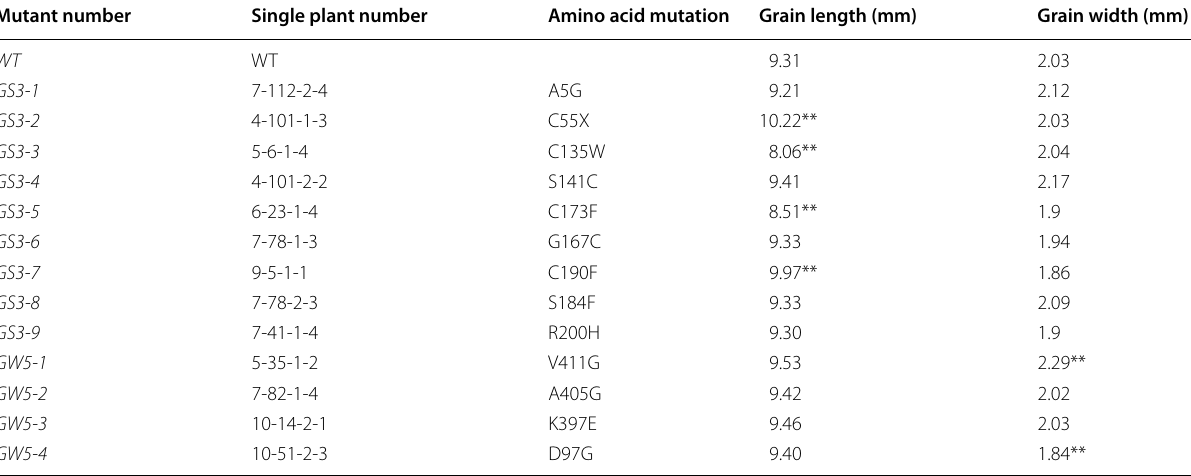
*: represents significant variation at p < 0.05; **: represents highly significant variation at p < 0.01